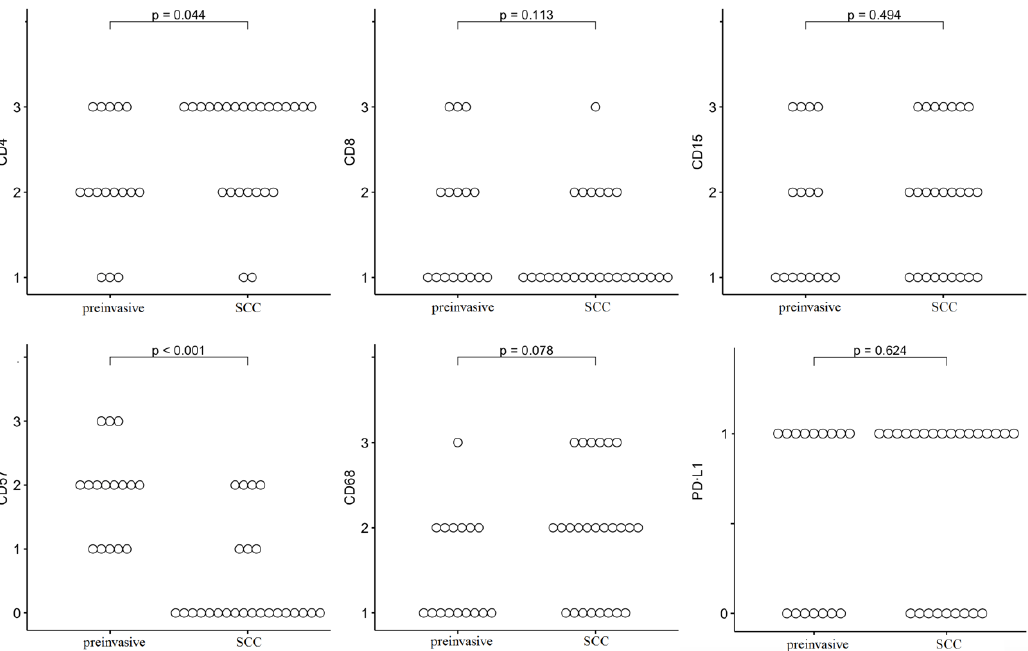
Figure 4. Comparative statistical analysis of CD4, CD8, CD15, CD57, CD68 and PD-L1 Combined Positive Scores (CPSs), the last being graded as low (0, <1) and high (1, ≥ 1) between preinvasive squamous cell lesions and SCC. Each circle represents a patient.